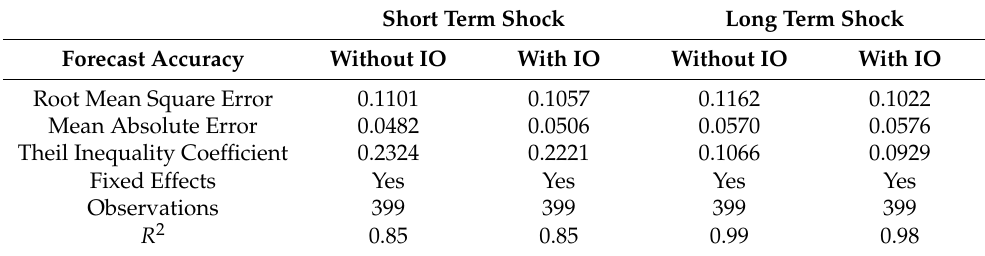
Table 6. Sample 2005–2011—VAR using 10 years interest